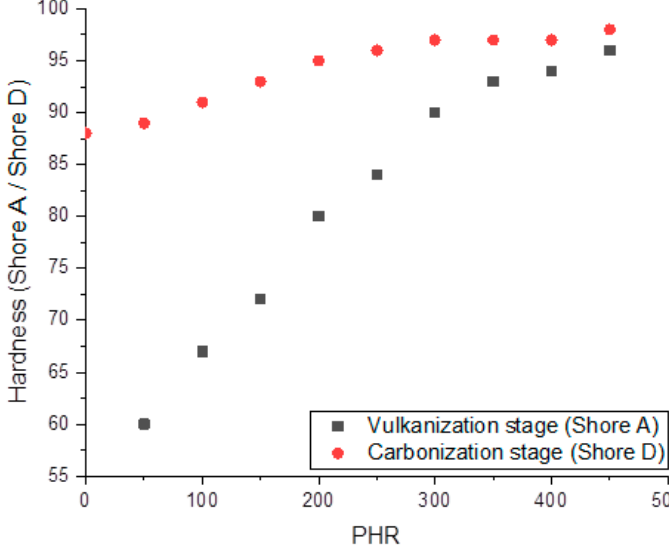
Figure 6. Dependencies of Shore A (for vulcanized composites) and Shore D (for carbonized composites) hardness on the filling degree.